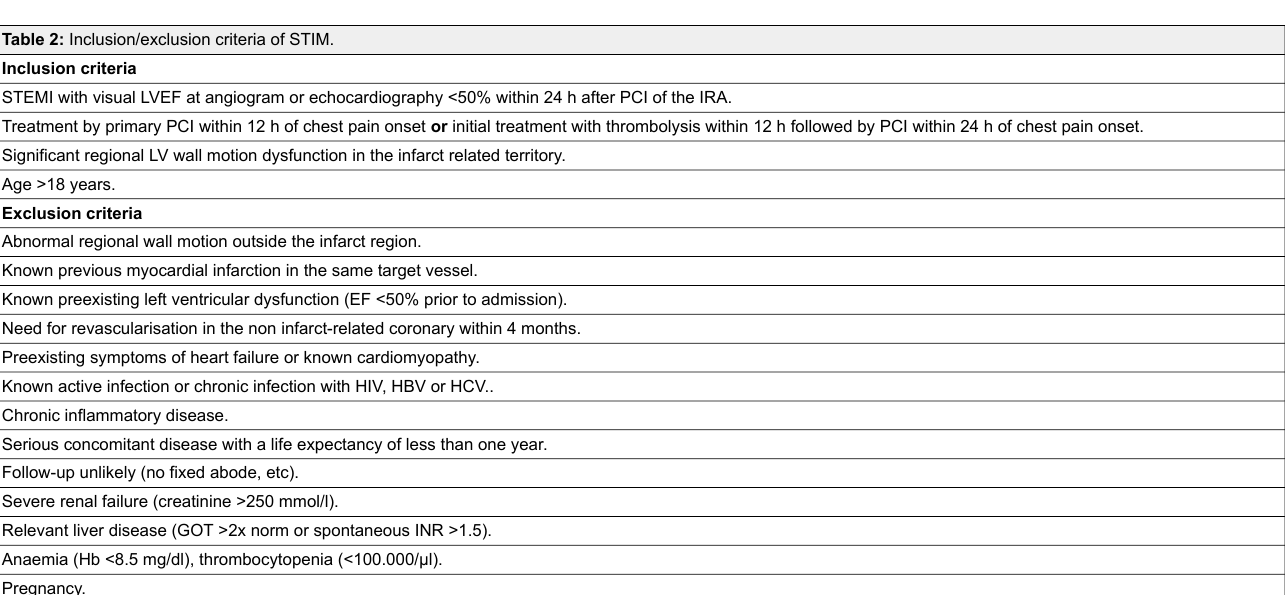
Table 2: Inclusion/exclusion criteria of STIM. Inclusion